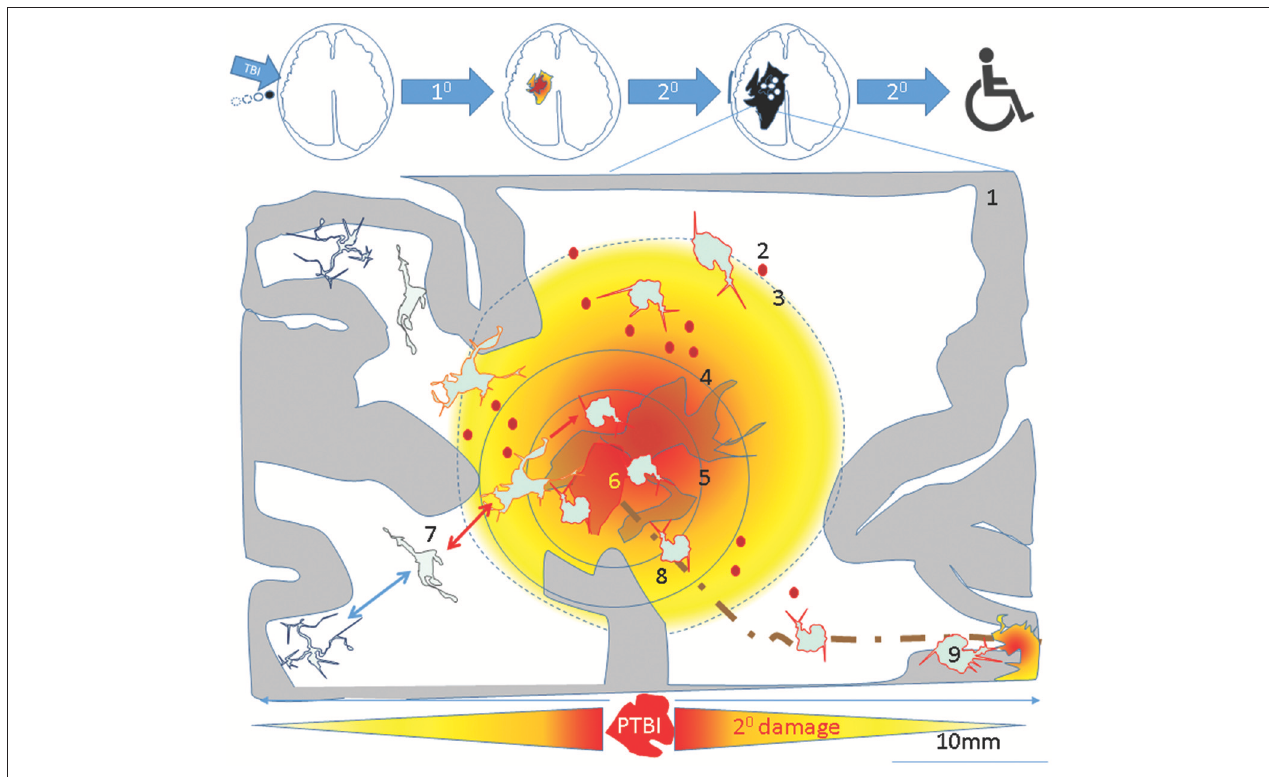
FIGURE 4 | A theoretical schematic (top) shows evolution of the primary PTBI injury into disability. A PTBI brain schematic focused on inflammatory microglia over nine regions outlines possible mechanisms underlying magnification of primary injury and spread to remote sites. 1- intact brain tissue, 2-petechiae in injured brain which perpetuate blood brain barrier compromise, hemorrhage, delayed cell death, 3- a gradient of local DAMPs/NAMPs may combine with circulating inflammatory mediators (via broken BBB) to recruit and activate microglia in penumbra rendering tissue vulnerable to secondary damage, 4- region with neuronal apoptosis/pyroptosis and neural stem cell recruitment and apoptotic death., 5- regions of astrocyte destruction and reactive gliosis which stems from 6-Focal injury. The focal injury turns into a permanent cavity in part due to oncotic cell death and axonal destruction (brown dotted line). 7- Normal surveying microglial acquire various reversible/irreversible activation states as they travel along the DAMP/NAMP gradient. 8. Irreversibly activated microglia could migrate away from injury core toward remote deeper regions. 9-Pyroptosis of activated microglia in remote regions connected to injury site (via pathways that were axotomised by injury) may mediate secondary axotomy and remote neurodegeneration (210,